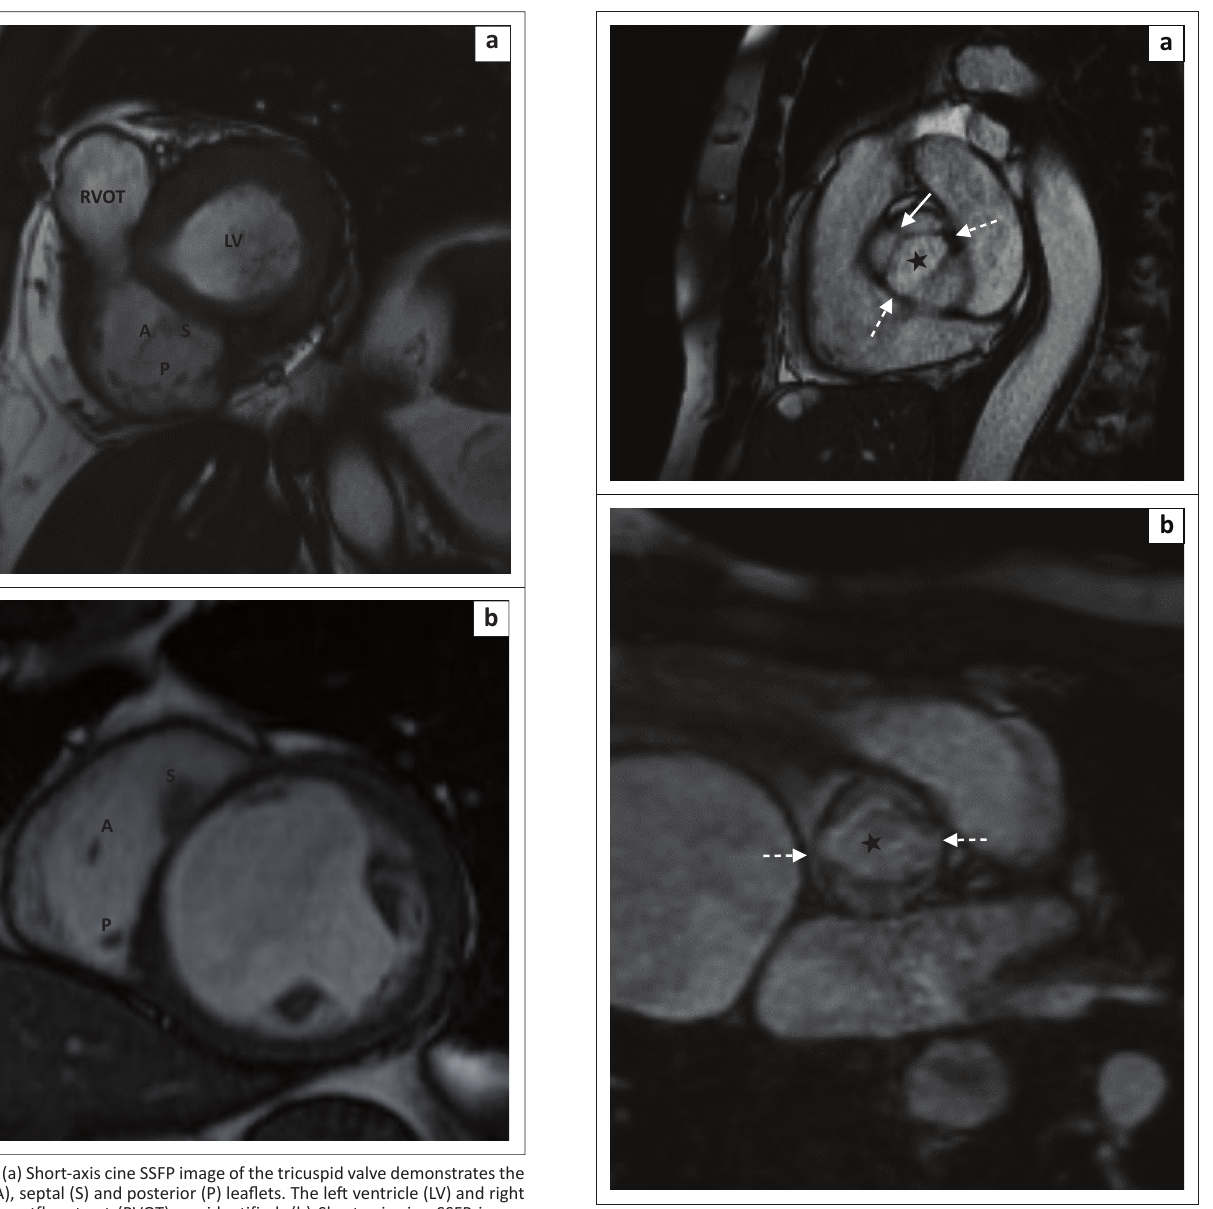
FIGURE 6: (a) Short-axis cine image of the aortic valve demonstrates the very characteristic ‘fish mouth’ opening of the bicuspid aortic valve secondary to a raphe (solid white arrow). Two normal commissures can also be seen (dashed white arrows). Cine image available at https://www.youtube.com/ watch?v=sWx3JIax4DQ&feature=youtu.be; (b) Axial cine SSFP image of the aortic valve demonstrates only two coronary sinuses of Valsalva with two normal commissures (dashed white arrows) resulting in the characteristic ‘fish mouth’ opening of the bicuspid aortic valve. Cine image available at https://